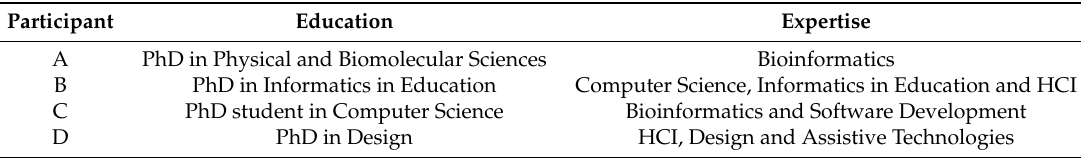
Table 3. The participants of the heuristic evaluation.